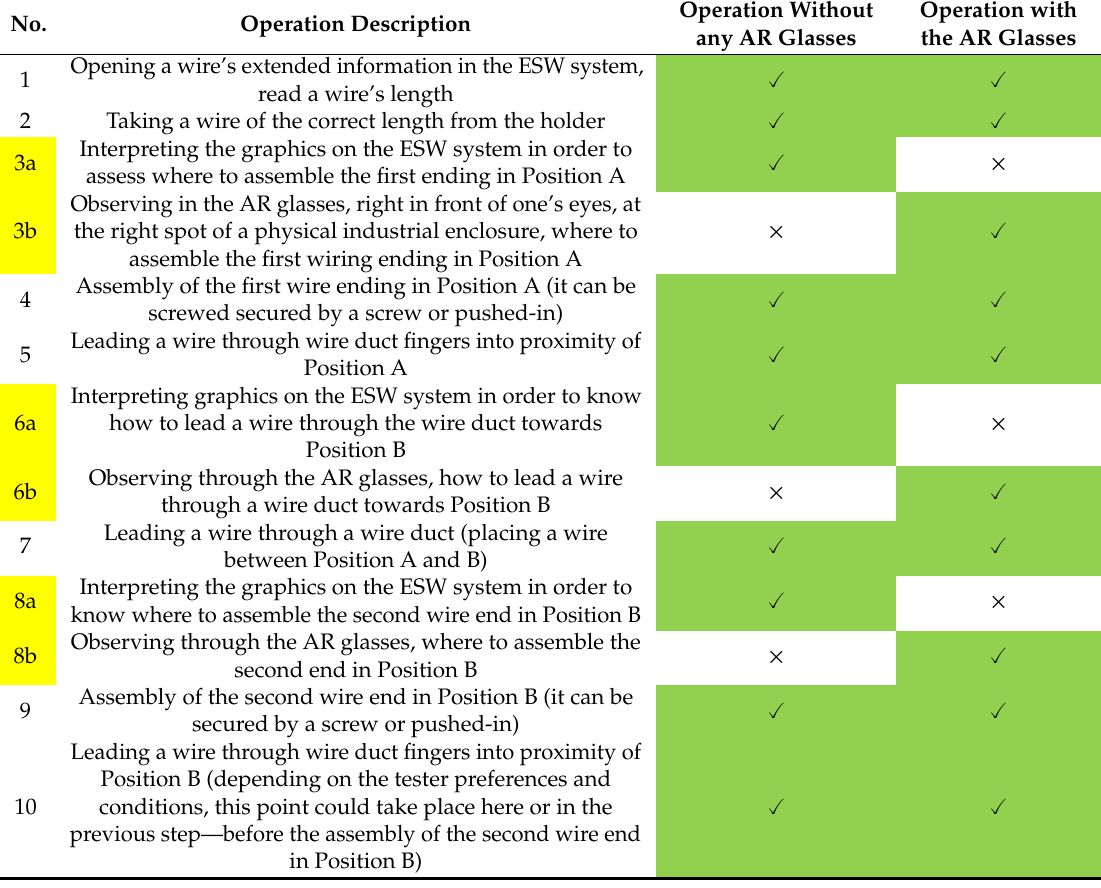
Table 1. Operations during step (2) of the test procedure (optional operations in the case of the test without any AR glasses or with the AR glasses are marked as ‘a’ or ‘b’ next to the number or particular